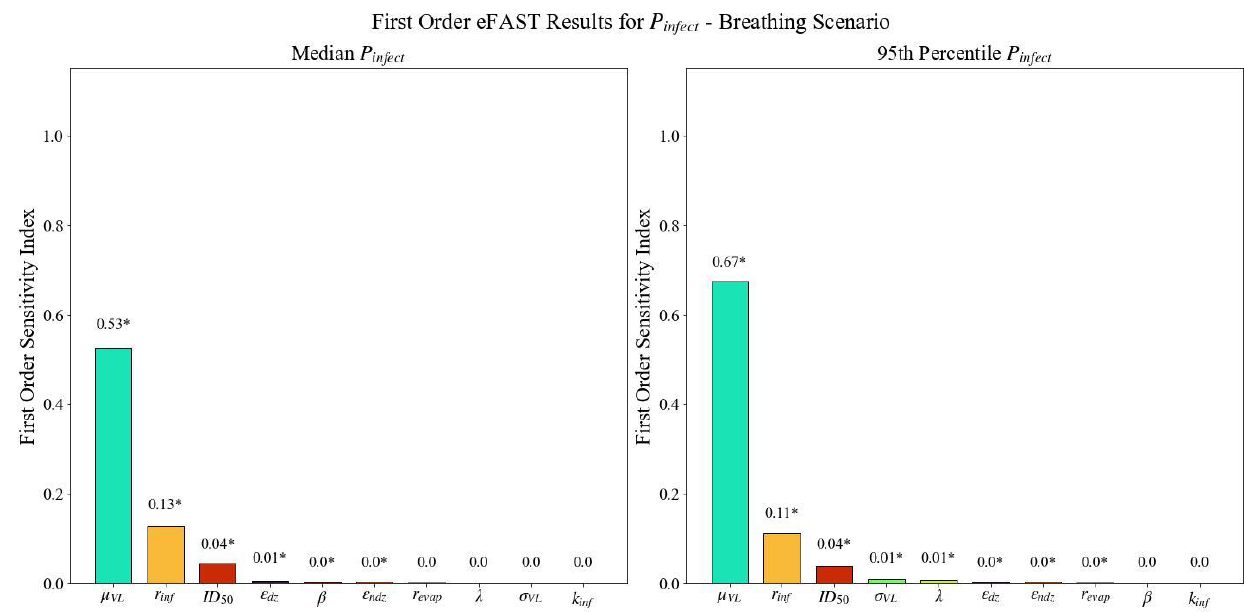
Figure A6. First-order sensitivity indices (ordered from largest to smallest) derived using eFAST for the median P infect and 95th percentile of P infect with breathing as the emission mechanism. Asterisks (*) indicate statistically significant sensitivity indices ( α = 0 .01).